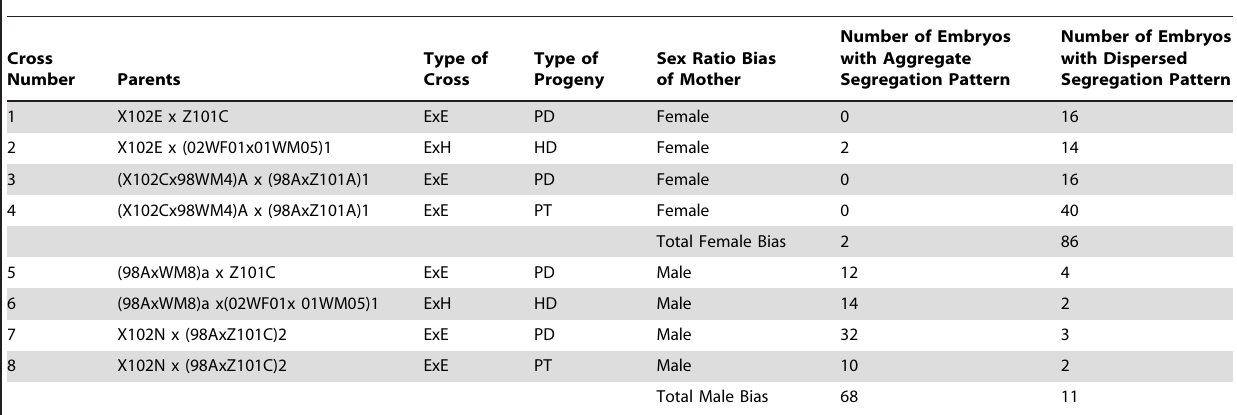
Table 5. Mitochondrial Segregation Pattern in Pure and Hybrid Crosses of Diploid and Triploid Mytilus .